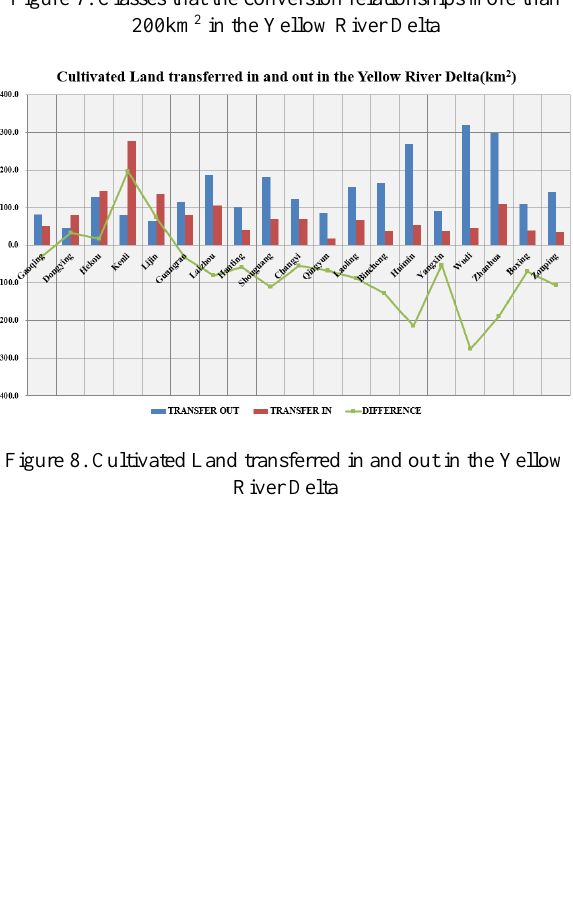
Figure 7. Classes that the conversion relationships more than 200km 2 in the Yellow River Delta